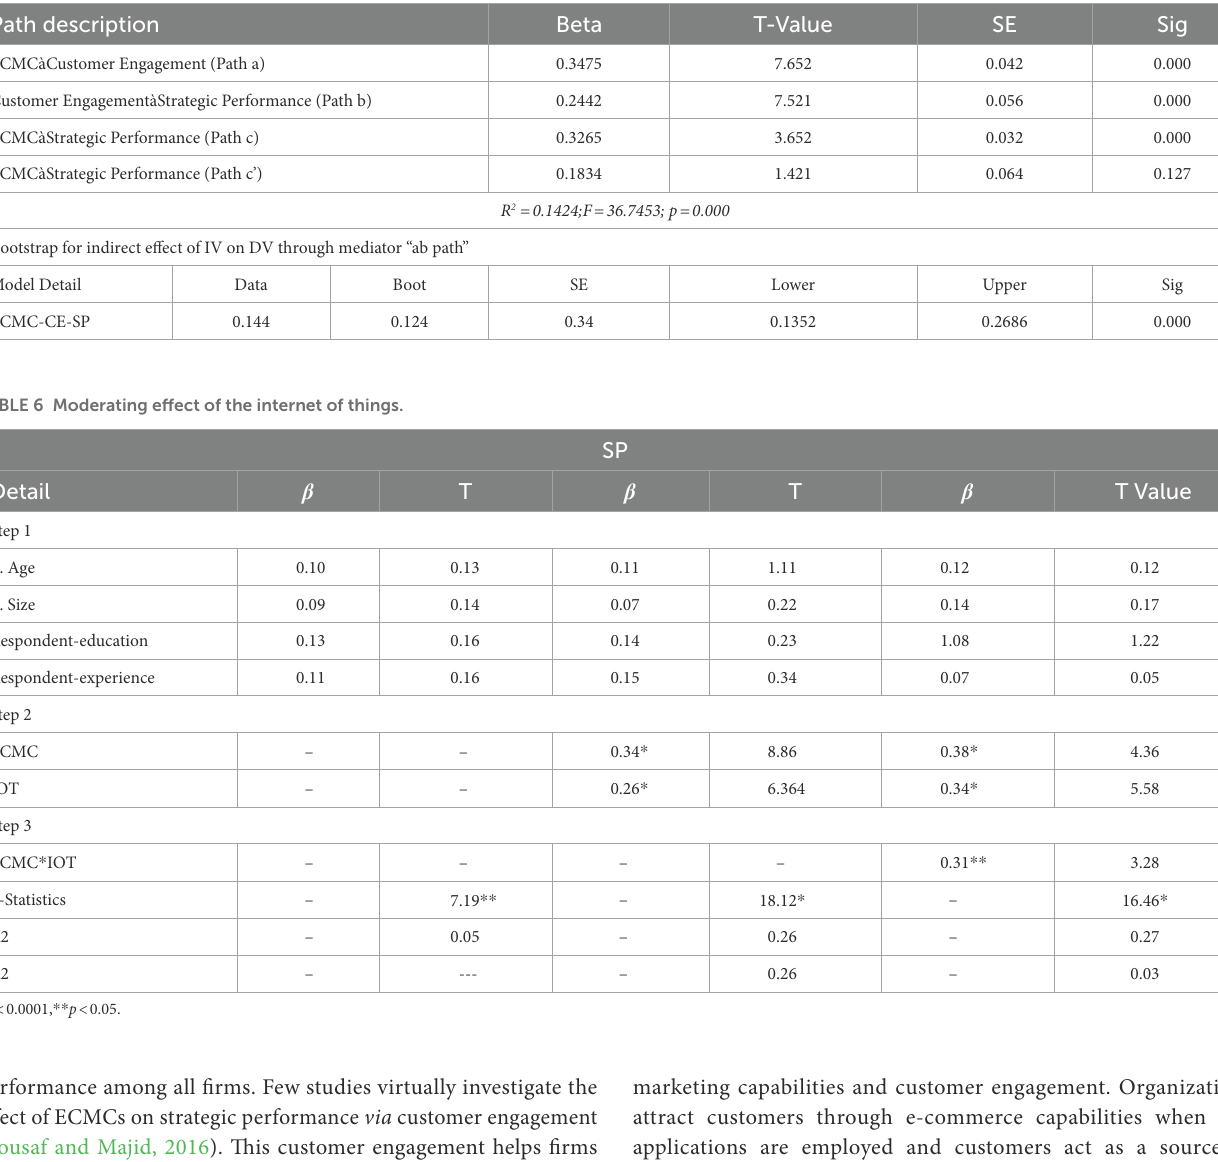
TABLE 5 Mediating effect of customer engagement between ECMCs and strategic performance.